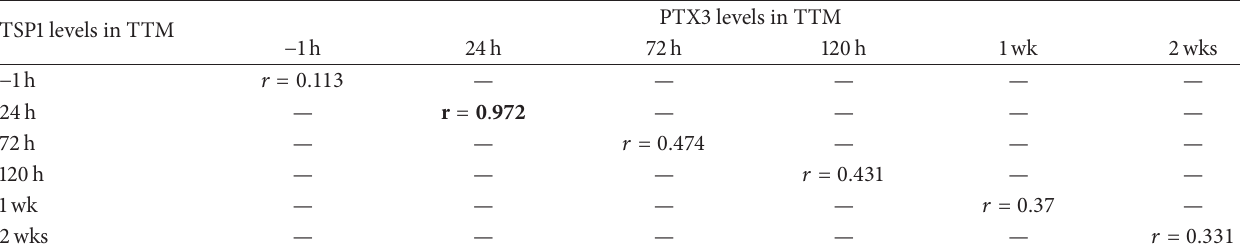
Table 1: Correlations between PTX3 and TSP1 levels at different time points in TTM. For the test group TTM there were significant positive correlations between levels of PTX3 and TSP1 at 24 hours ( 𝑟 = 0.972 , 𝑝 < 0.05 ) and poor correlations between levels of PTX3 and TSP1 at 72 and 120 hours, 1 week, and 2 weeks (Pearson test for correlations).